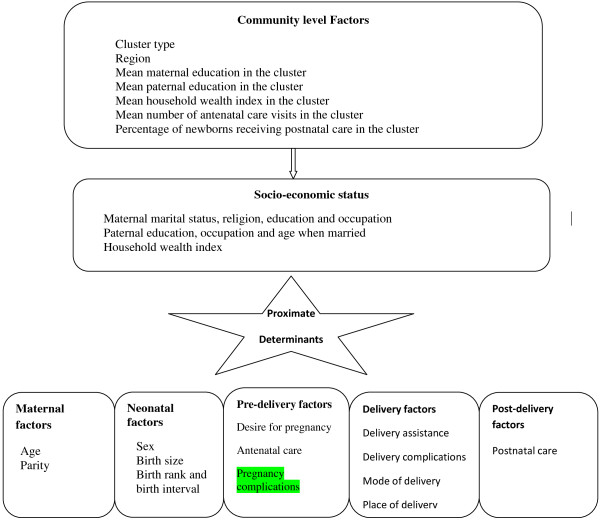
Conceptual framework for factors influencing neonatal mortality.